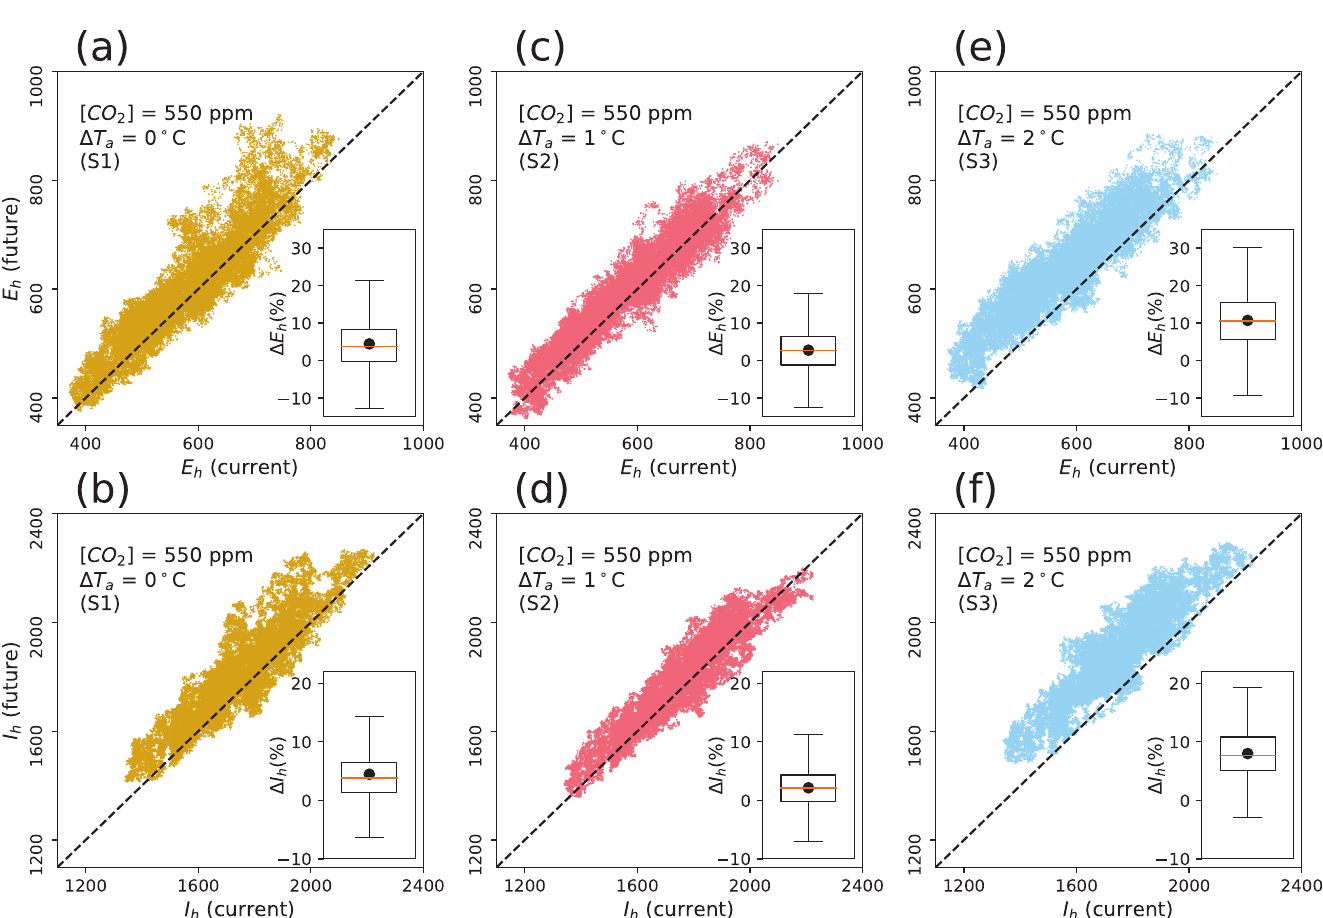
Fig 9. Comparison of exposed ( E ) and infected ( I ) malaria cases under climate change scenarios. Left column: One-to-one comparison between cases under present (S0—current) and elevated [CO 2 ] (S1—future) conditions. Middle column: One-to-one comparison between cases under present (S0—current) and elevated [CO 2 ] (S2—future) conditions. Right column: One-to-one comparison between cases under present (S0—current) and elevated [CO 2 ] (S3—future) conditions. The inset boxplots show the difference between cases in current and future conditions. Top row shows the values of exposed cases, bottom row shows the values of infected cases. Black dots represent the mean values.